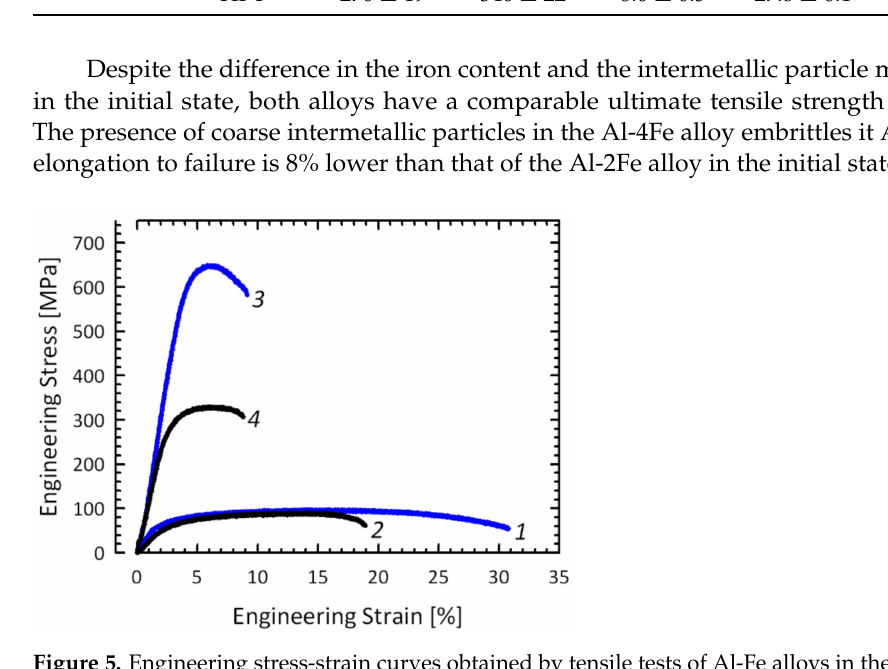
Figure 5. Engineering stress-strain curves obtained by tensile tests of Al-Fe alloys in the as-cast state (1: Al-2Fe, 2: Al-4Fe) and after HPT (3: Al-2Fe, 4: Al-4Fe). For the sake of clarity, only one curve is provided for each